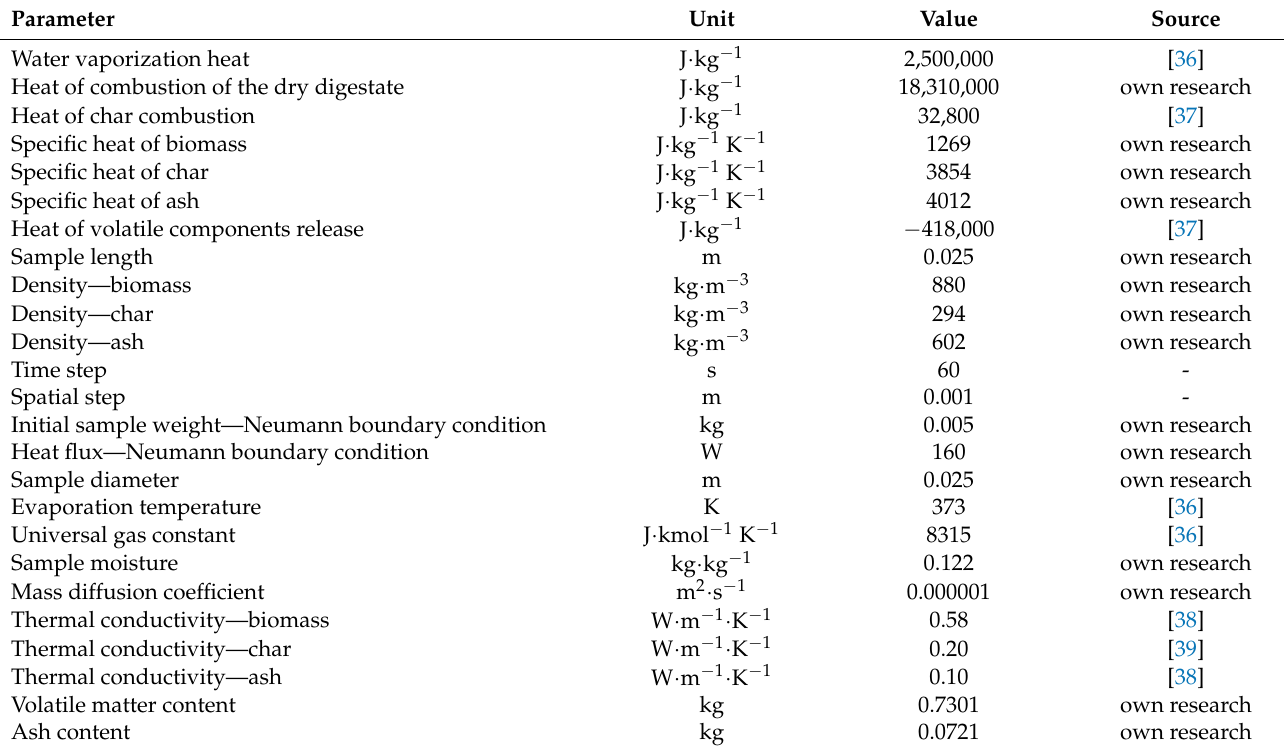
Table 3. Data for simulation